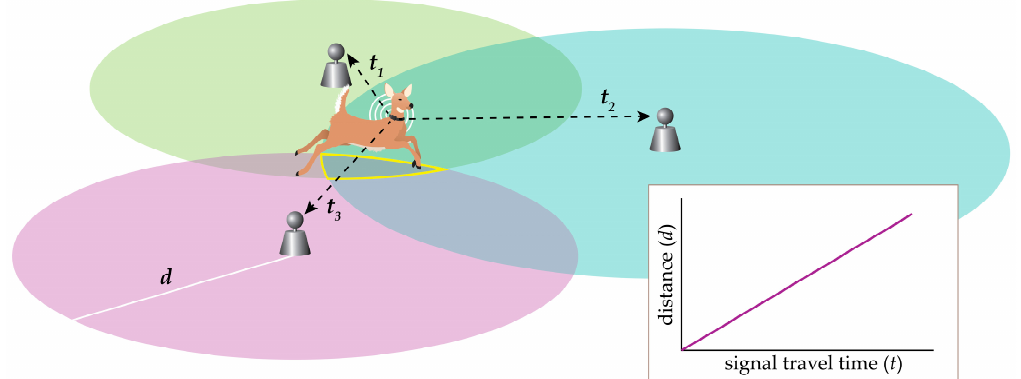
Figure 5. UWB positioning using TOA (time of arrival) trilateration. A tag (worn by the deer) emits UWB pulses which are received at each of the three anchor nodes. Based on a known signal speed and the propagation delay (signal travel time, t ), each receiver can calculate its distance, d , from the tag. The area where the three distances intersect (shown with a yellow outline) is the estimated position of the tag [91,93].